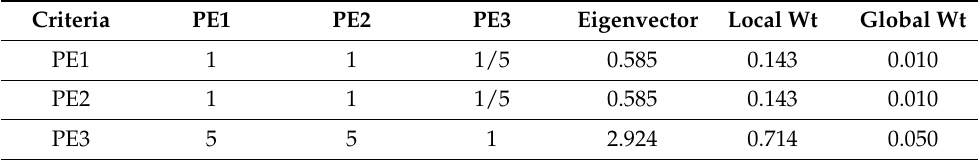
Table A3. Performance subcriteria comparison